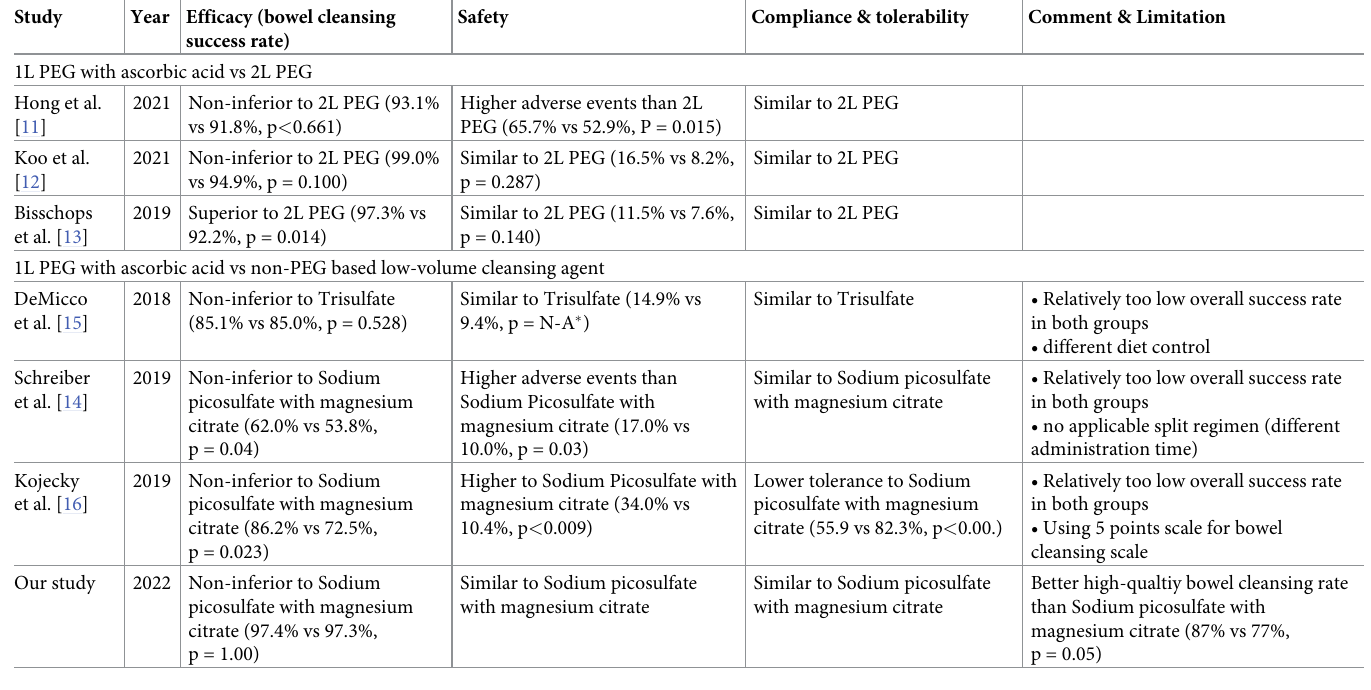
Table 1. Summary data on randomized controlled trial for 1L polyethylene glycol with ascorbic